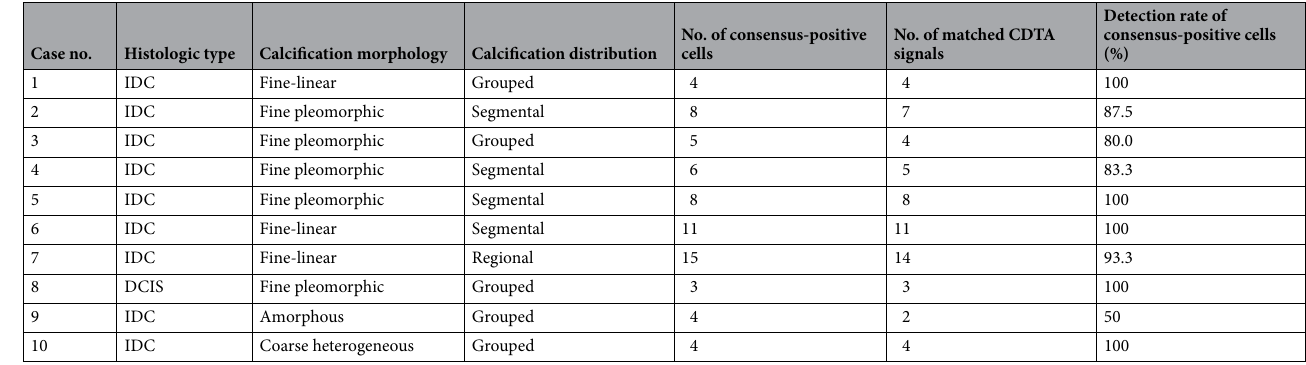
Table 3. Calcification characteristics and detection rate of consensus-positive cells for each case. IDC invasive ductal carcinoma, DCIS ductal carcinoma in